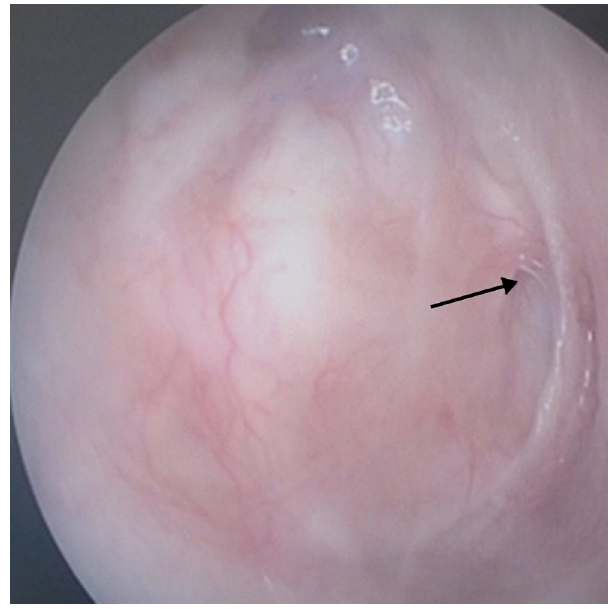
Figure 3 Perforation between remnant tympanic membrane and cartilage part of the graft seven months after the